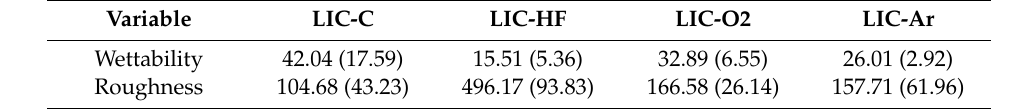
Table 4. Mean and standard deviation (SD) values of wettability (degree) and roughness (Ra, nm) in the leucite-reinforced feldspar ceramic (LIC) group (C: control; HF: hydrofluoric acid; O2: oxygen; Ar: argon).